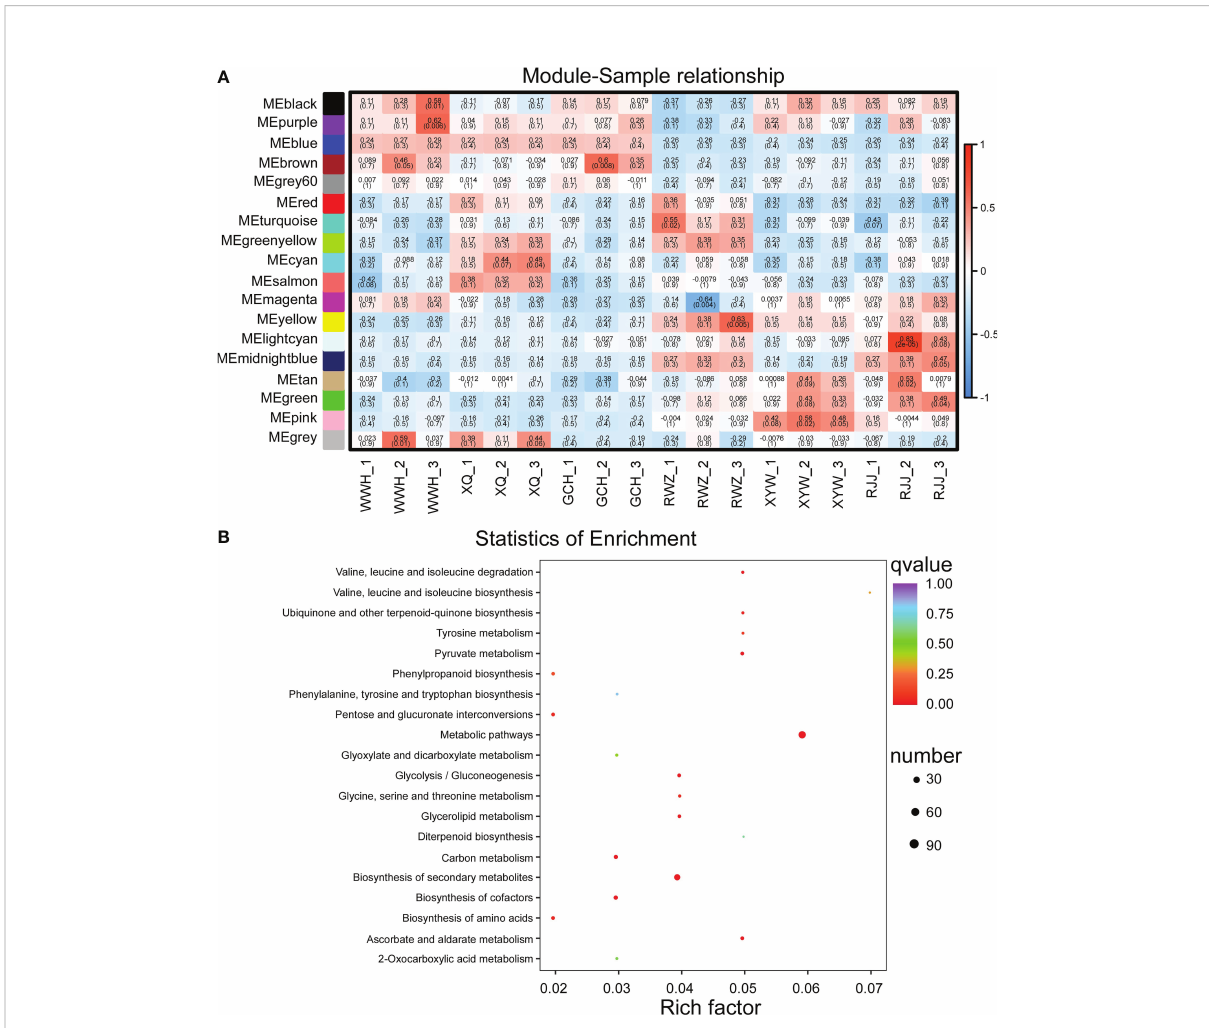
FIGURE 3 WGCNA of RNA-Seq data. (A) Eigen gene adjacency heatmap. (B) KEGG enrichment of DEGs in the blue module. Each bubble represents a metabolic pathway. A larger bubble size indicates a more considerable impact factor. The bubble colors represent the p-values of the enrichment